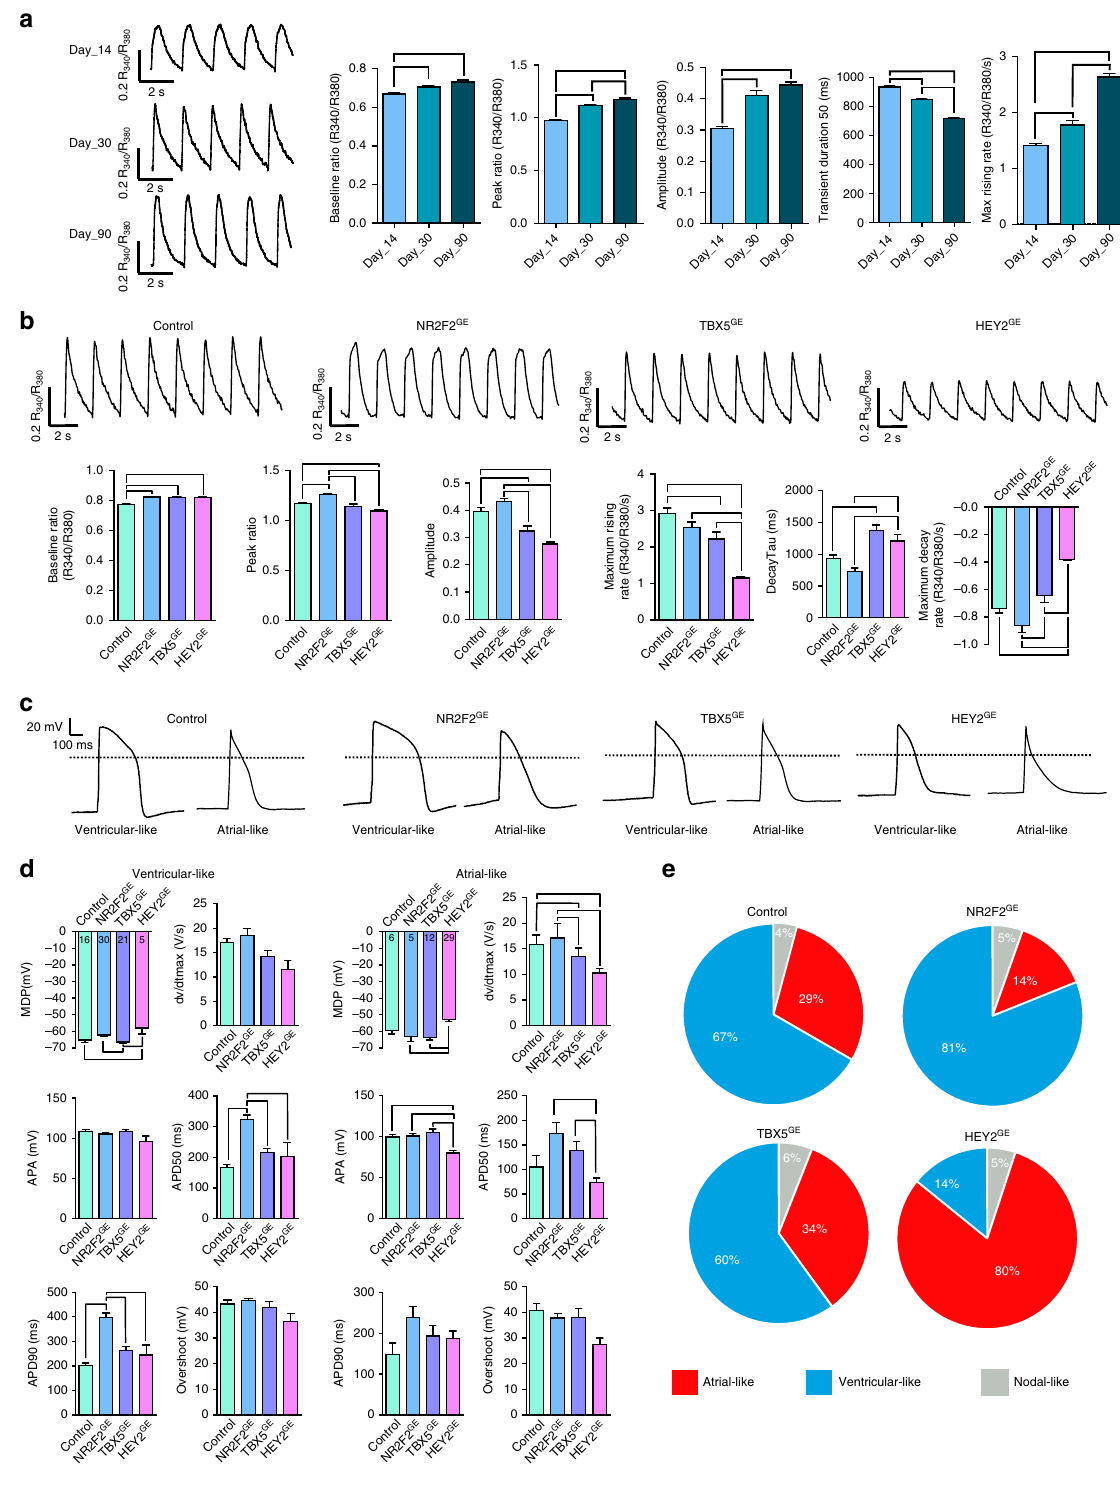
adult heart genes expressed during prolonged culture (Supple- mentary Fig. 5B). To investigate whether ventricular markers are enriched in cardiomyocytes at later time points, we assessed the top 100 atrial and ventricular enriched genes (i.e., measuring the greatest fold-change with empirical Bayes moderated unpaired t - test assuming unequal variance with p < 0.05) (Supplementary Fig. 5C) and graphed the percentage of atrial versus ventricular